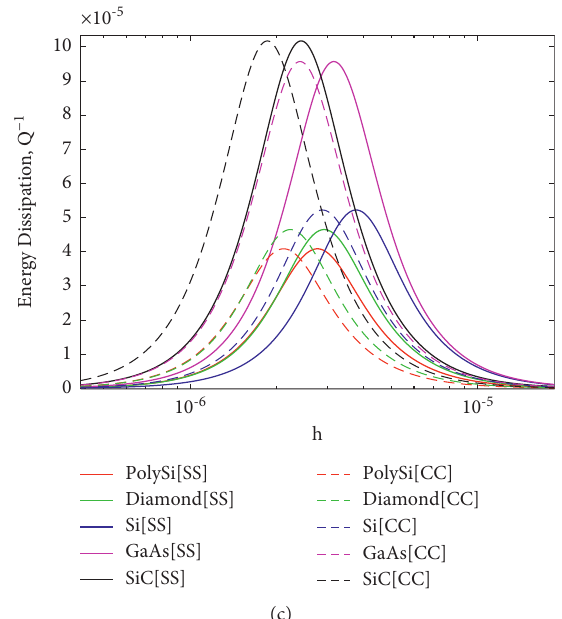
Figure 3: Comparison of energy dissipation, Q − 1 vs. thickness, h of a rectangular plate for simply supported (SS) and clamped-clamped (CC) boundary conditions vibrating in Mode-I with (a) l / h � 0, (b) l / h � 0.5, and (c) l / h �